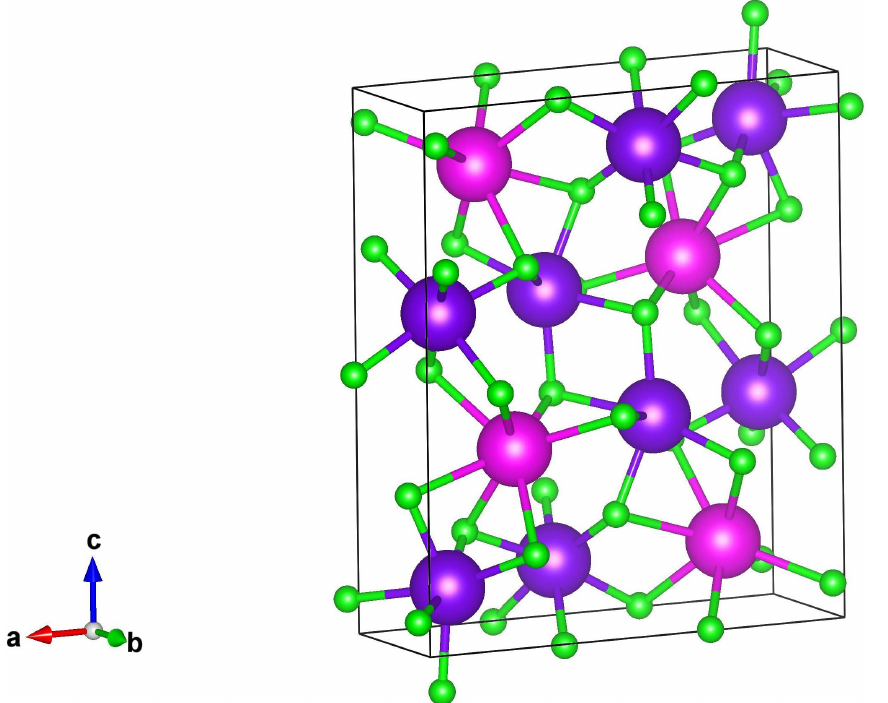
Figure 1. The orthorhombic structure of Eu 3 O 4 , in which the purple, magenta and green spheres represent the Eu 3 + , Eu 2 + and O 2 − ions, respectively. The black box represents one unit cell of the Eu 3 O 4 crystal. The model was constructed using VESTA TM software package